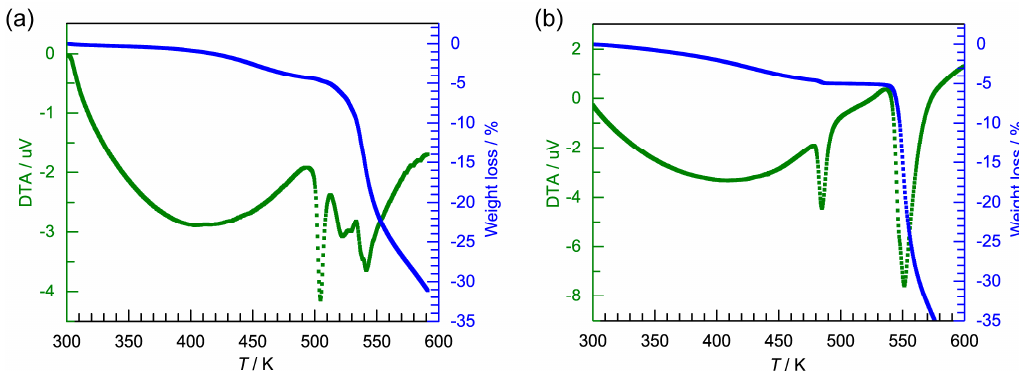
Figure 1. Thermogravimetry and differential thermal analysis (TG/DTA) curves of 1·PF 6 ( a ) and 1·AsF 6 ( b ).